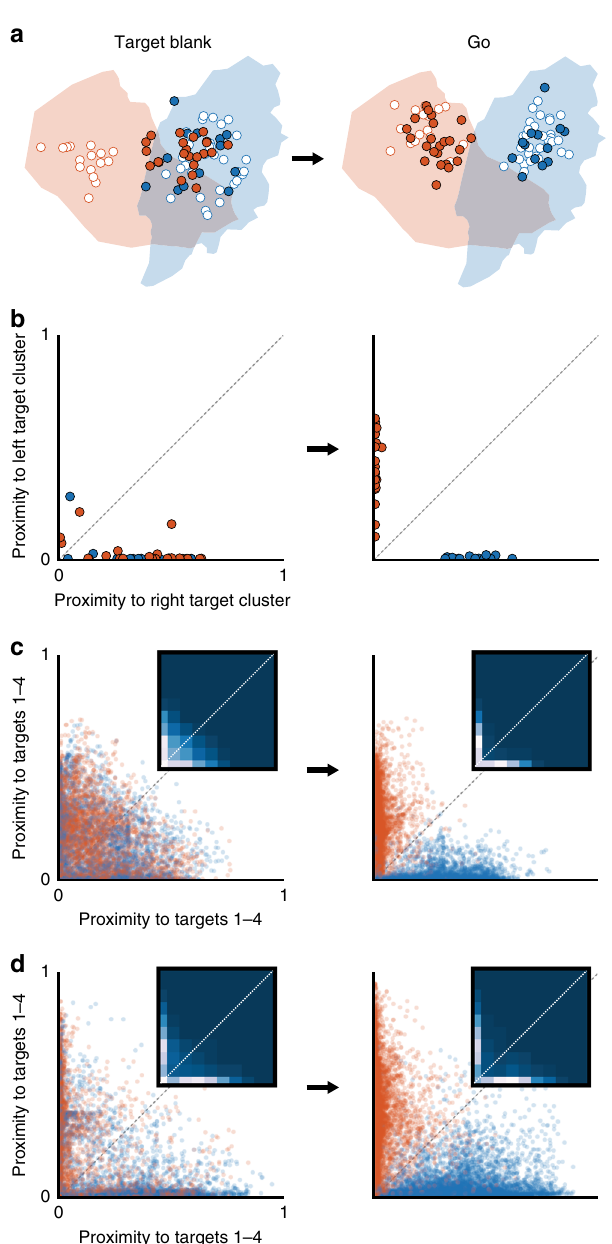
Fig. 5 Low-dimensional neural states on 2-Target trials. a Neural states during planning (left plot) and movement execution (right plot) for all left/ right target trials during an example session. Filled red circles correspond to trials with a cue to the left target, fi lled blue circles a cue to the right target. Open circles represent 1-Target left (red) and right (blue) trials. b Proximity plots of the left/right 2-Target trials in a . c Left: proximity plots of planning activity (Target Blank epoch) for all 2-Target trials, monkey C. Inset heat map shows the high concentration of points along the x - and y -axes. Right: proximity plots of execution-related activity (Go epoch) for all 2-Target trials, monkey C. d Same as c for monkey M